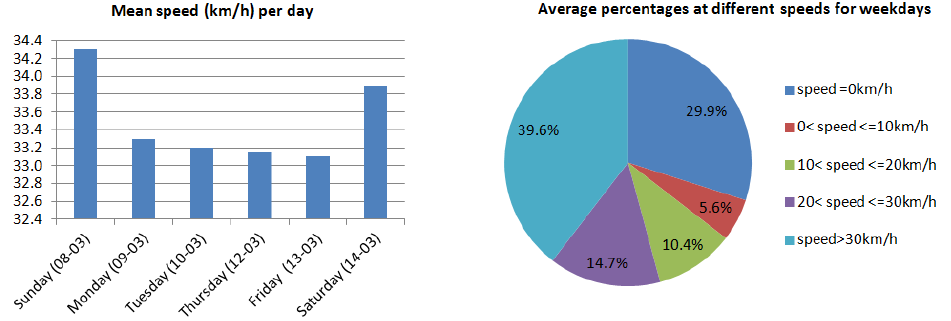
Figure 6. Mean speeds and average percentages of taxicabs at different speeds.